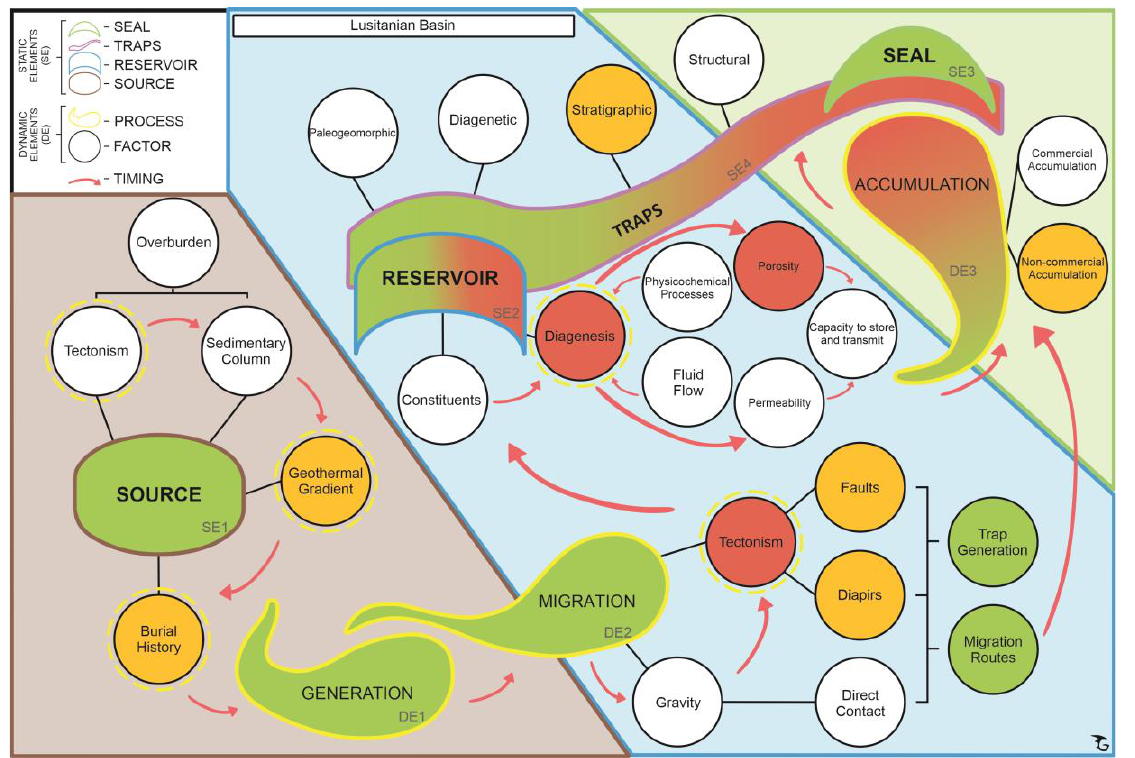
Figure 19. Illustrative scheme of the analysis of the static and dynamic elements in the study of the Abadia Formation’s reservoir in the Lusitanian Basin. Legend: Elements, factors and processes that were successful, in green; elements, factors and processes that have not been successful, in red; factors and processes that were relevant in the formation of the petroleum system, in orange; and factors and processes that were not relevant in the formation of the petroleum system, in